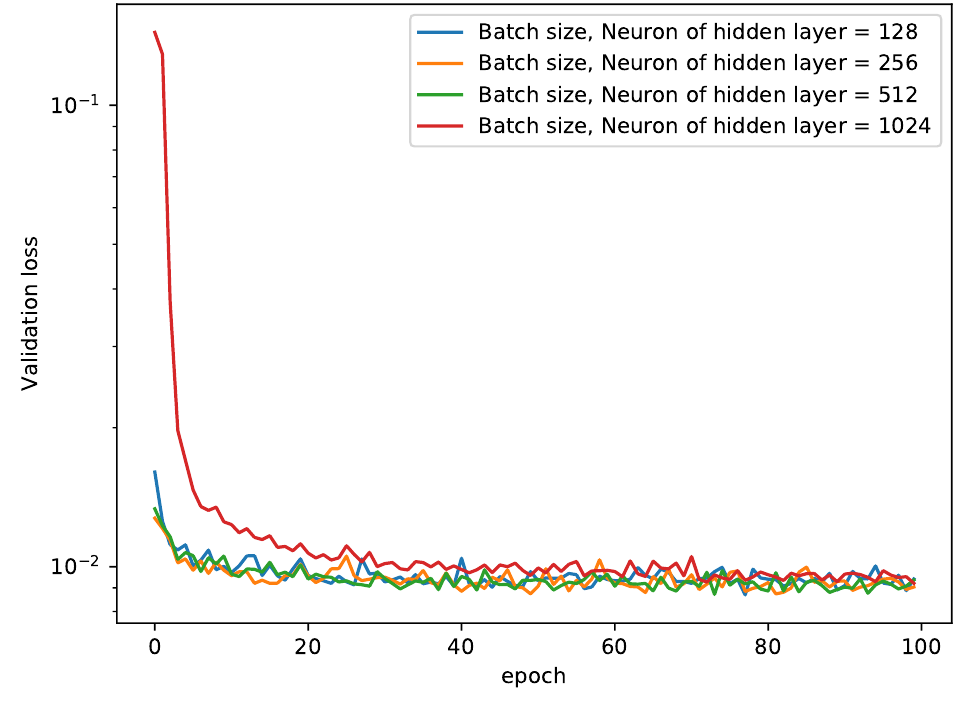
Figure 11. Comparison of the validation loss for various mini-batch sizes with log-scale for 3D- truncated tetrahedron